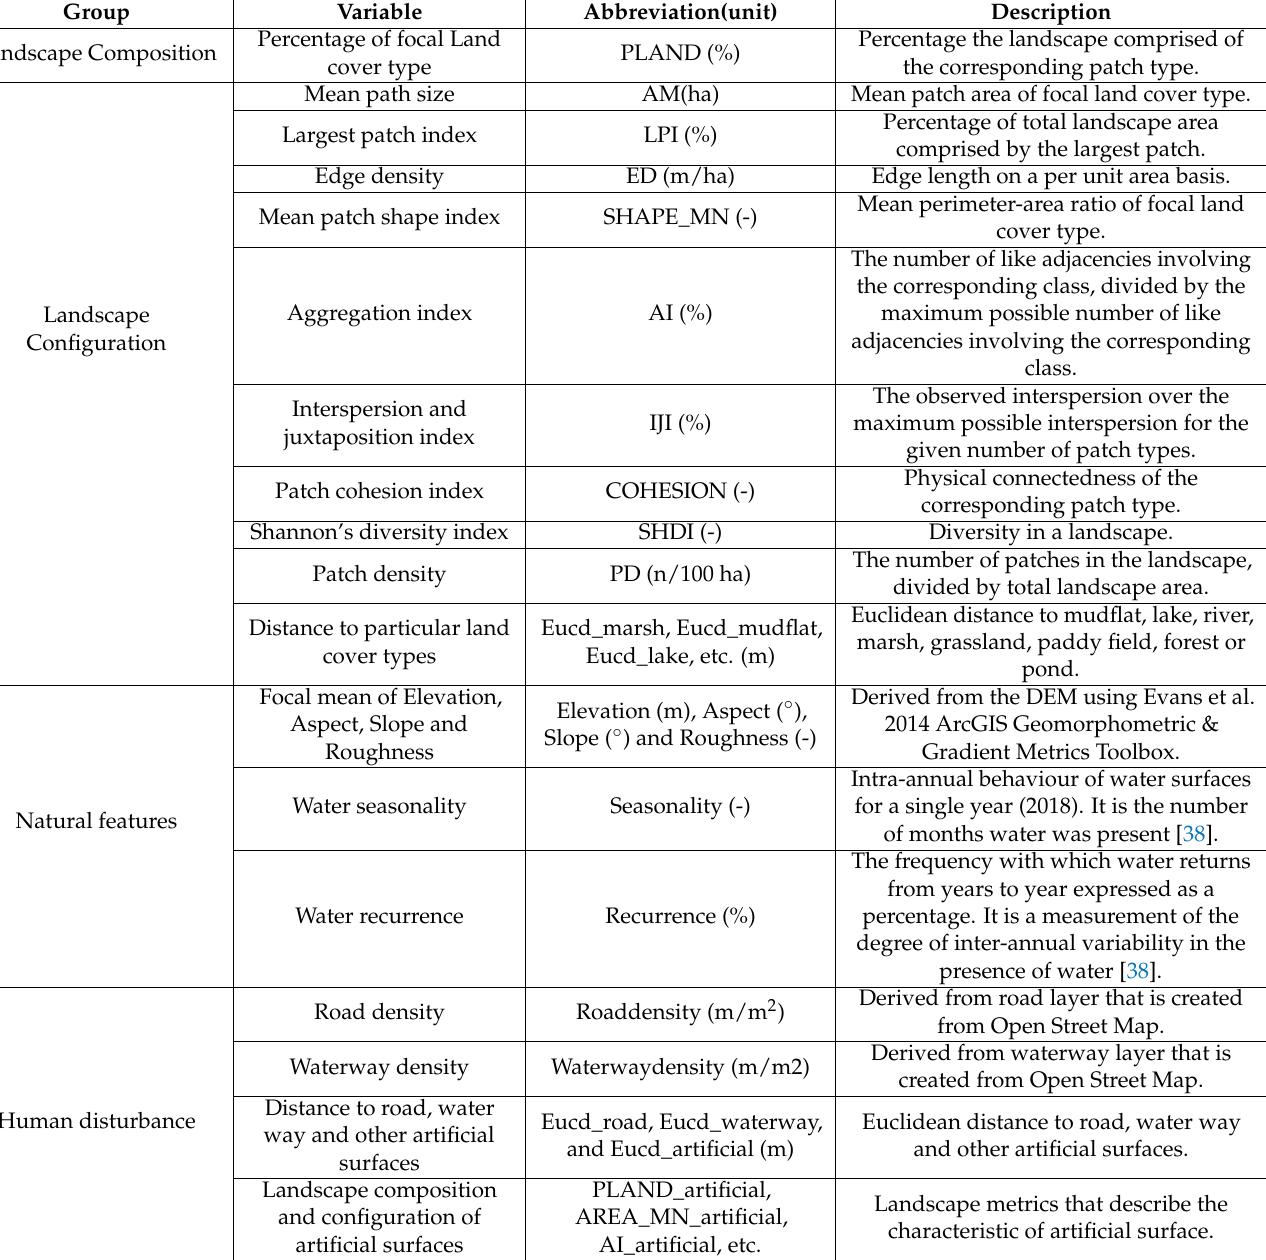
Table 1. Environmental variables considered for oriental white stork habitat selection analysis at the foraging and roosting scales. All layers except the distance variables were produced at 8 different spatial